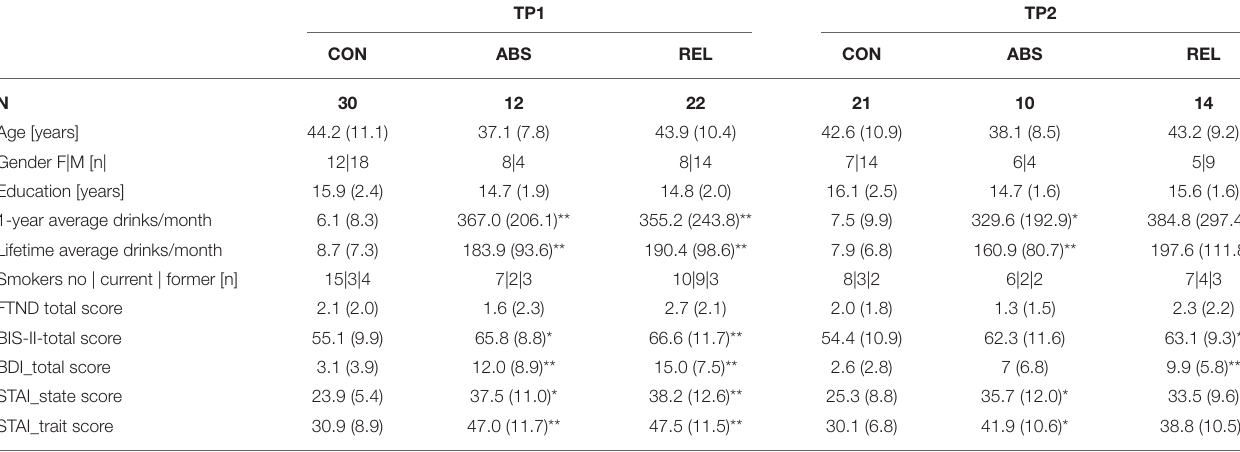
TABLE 1a | Demographic description of the three groups: Controls (CON), Abstainers (ABS), Relapsers (REL). TP1 TP2